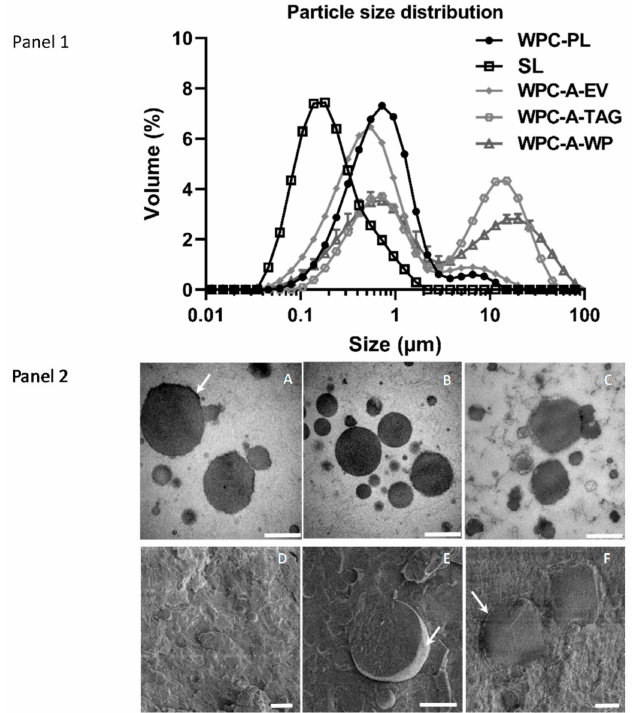
Figure 2. Particle size distribution and transmission electron microscopy ( Panel 1 ): Volume mean diameter for each of the 3.5% oil-in-water emulsions, WPC-A-EV, WPC-PL, WPC-A-TAG, WPC- A-WP, and soy lecithin (SL). n = 3. Values are presented as means ± SD. ( Panel 2 ): Micrographs from transmission electron microscopy (subpanels A, B, C) and cryo-scanning electron microscopy (subpanels D, E, F) of three emulsions. A and D: WPC-PL emulsion, B and E: WPC-A-EV emulsion, C and F: SL emulsion. The scale bar for micrographs A–C is 500 nm, and D–F is 2 µ m. The arrow in A points out the dark layer, in E the arrow points out the lipid droplet’s smooth surface, and in F the arrow points out the thick and uneven surface of the lipid